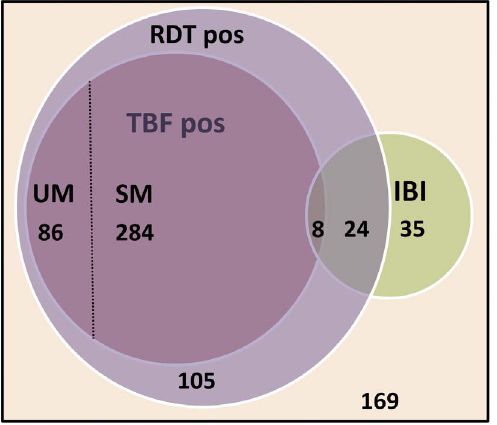
Figure 1. Numbers of children with positive microscopy, RDT and IBI. TBF, RDT and IBI results for all children (n=711), 169 children tested negative on all three items. Areas in Venn-diagram approximately to scale. TBF = thick blood film, RDT = rapid diagnostic test, IBI = invasive bacterial infection, SM = severe malaria, UM = uncomplicated malaria .